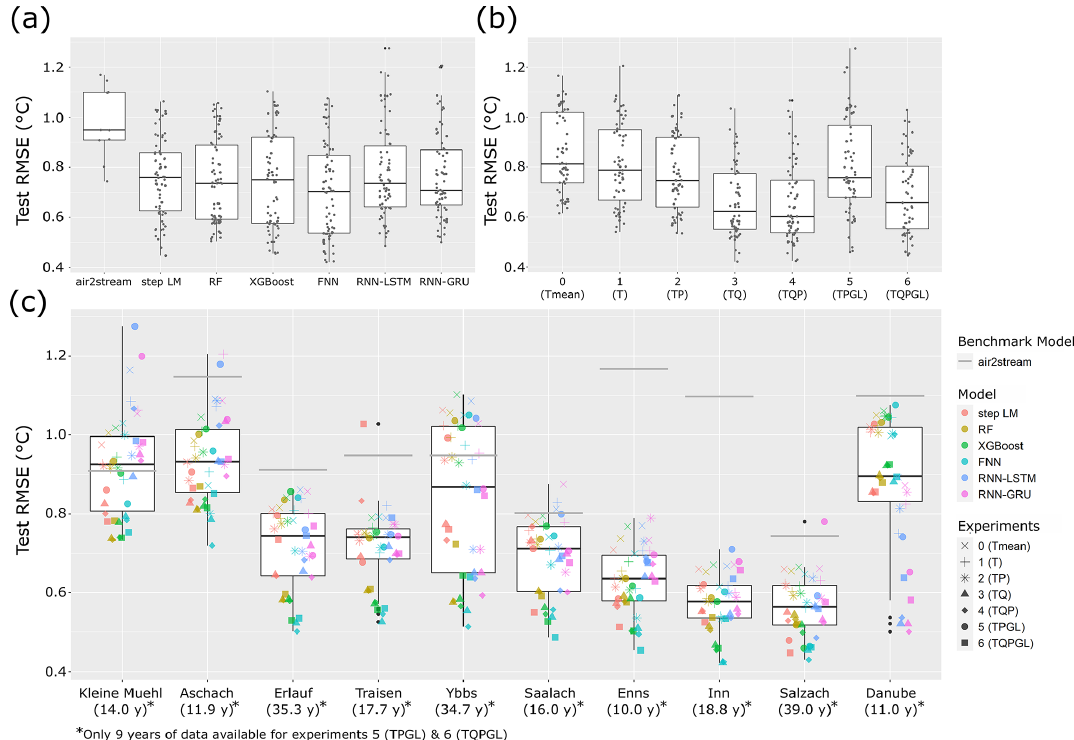
Figure 4. Boxplots of model performance comparing (a) the different machine-learning models, (b) the different experiments and (c) model performance in each catchment with additional scatter-plot overlay to show performance of individual combinations of catchments, models and experiments. The catchments in (c) are ordered by catchment size from smallest to largest with additional information of the available time-series length in parentheses below. The air2stream benchmark performance is shown as grey line for each catchment. Due to the much larger test RMSE values, LM performance is not shown to account for a better visibility.